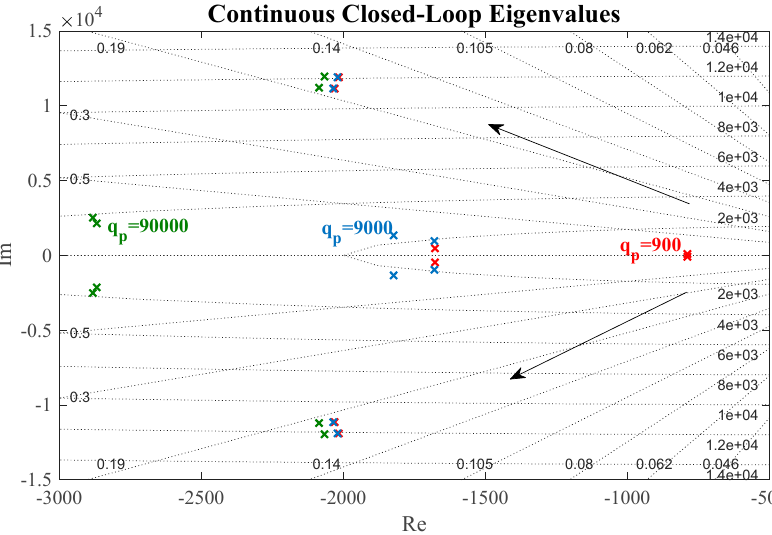
Figure 18. Closed-loop eigenvalues of the grid-connected inverter using the LQI power controller. The open-loop transfer function is given by